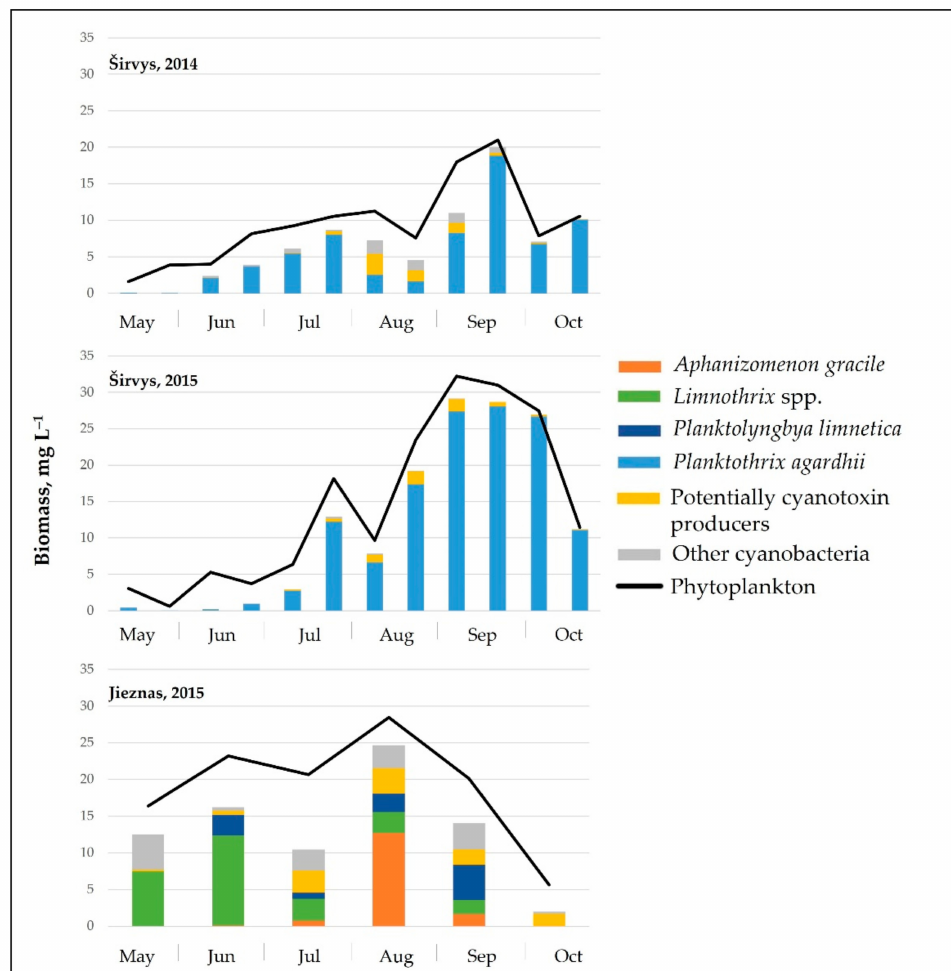
Figure 1. Seasonal variation in the biomass of potentially toxin-producing cyanobacteria species in the studied